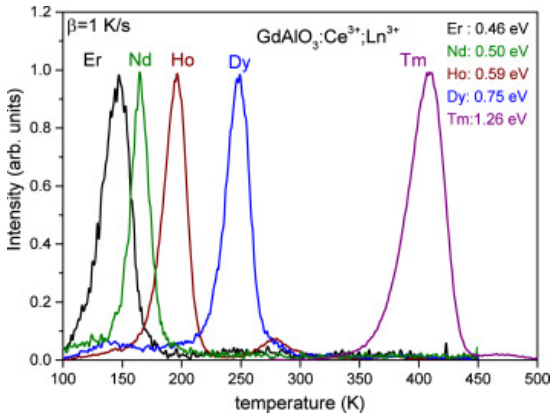
Figure 7. Normalized thermally Stimulated luminescence glow curves of GdAlO 3 :1% Ce 3+ ,1% Ln 3+ (Ln = Er, Nd, Ho, Dy, and Tm). All glow curves were recorded by measuring the Ce 3+ emission. Data obtained from Luo et al. [71].